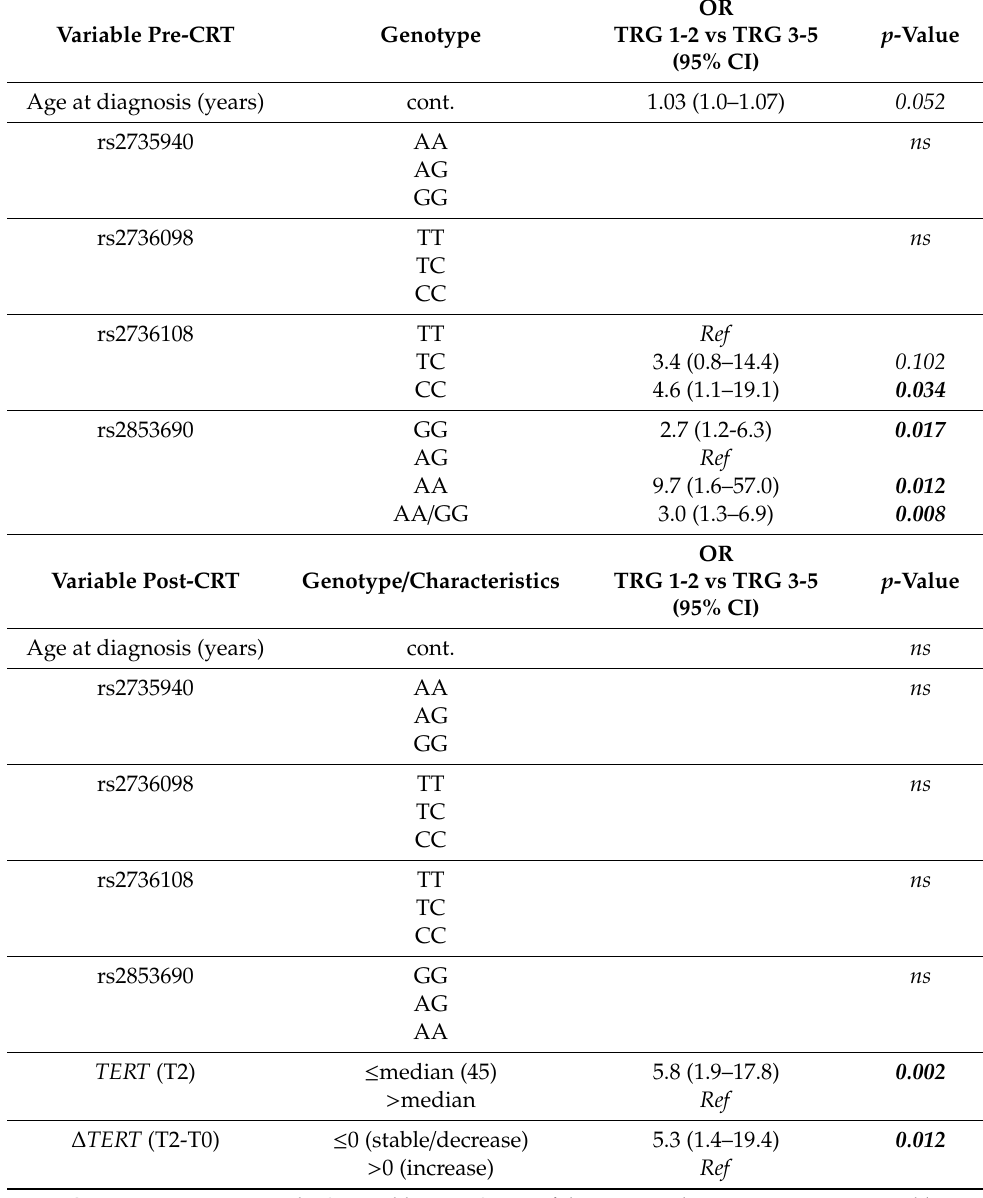
Table 2. Multivariable logistic regression analysis of TRG probability in rectal cancer patients pre and